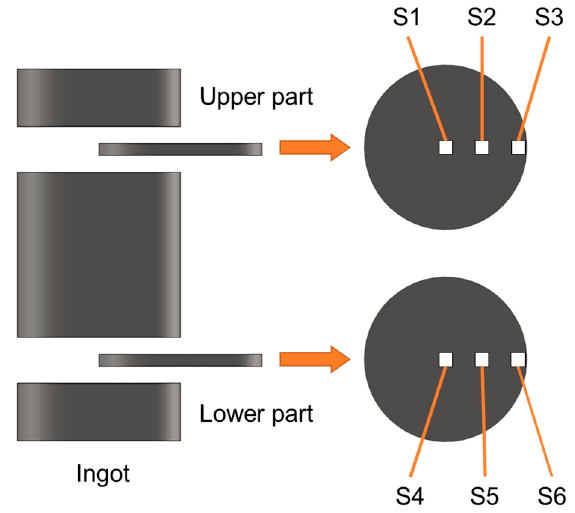
Figure 2. Schematic of sampling procedure (online version in color).